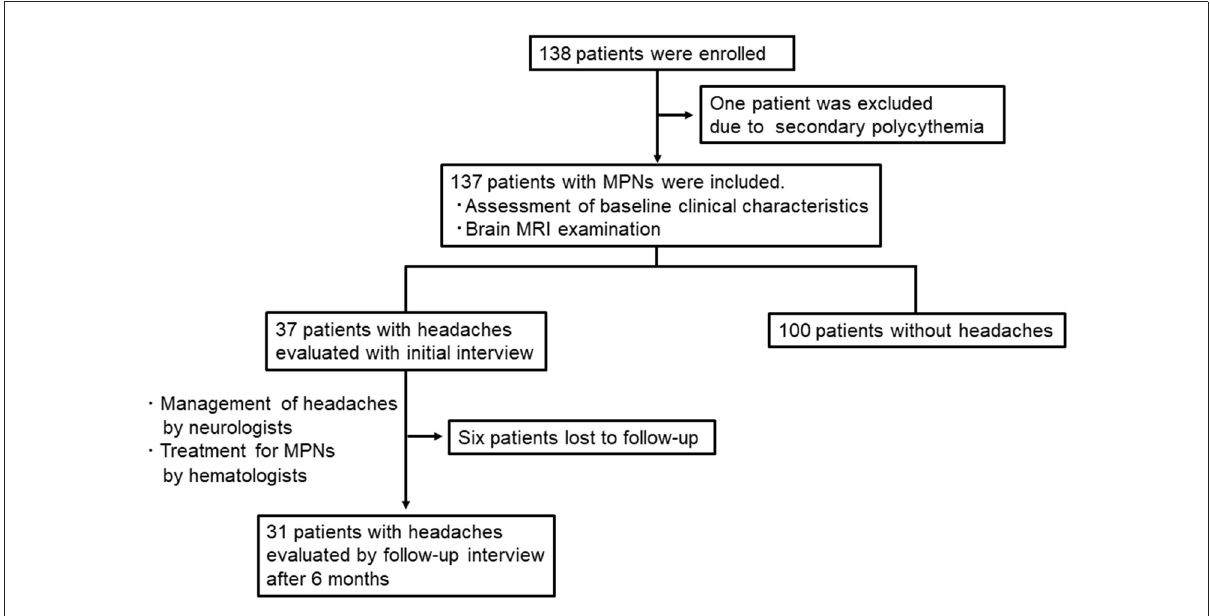
FIGURE1 Time frame and study flow gram in this